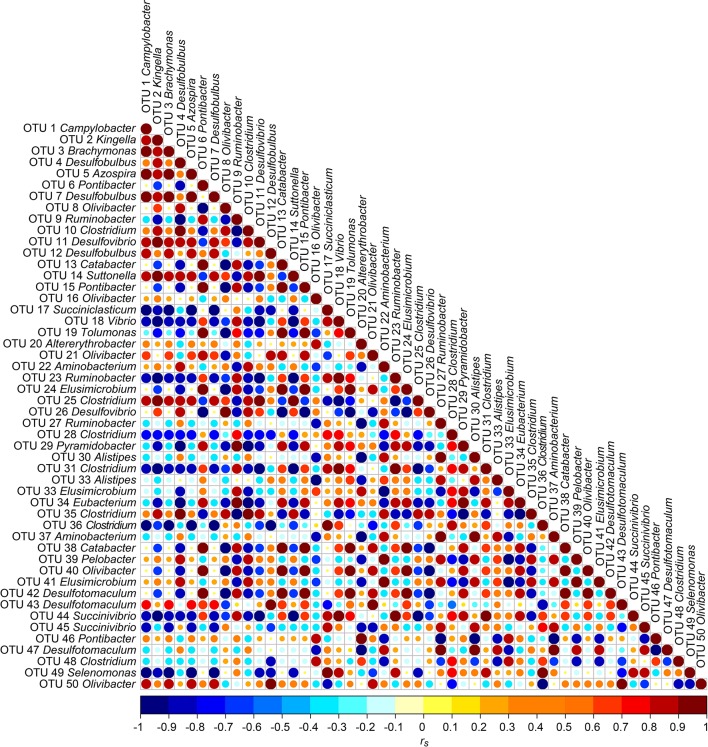
Correlation matrix between the 50 most abundant OTUs over all four sampling time points B (baseline), S1 (SARA 1), CB (challenge break), and S2 (SARA 2): Positive correlations are shown in red and negative correlations in blue. Color intensity and the size of the dots are proportional to the correlation values [rs] within a correlation group.